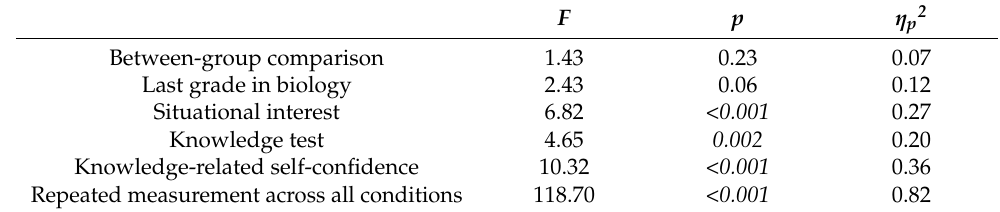
Table 2. Outcomes of